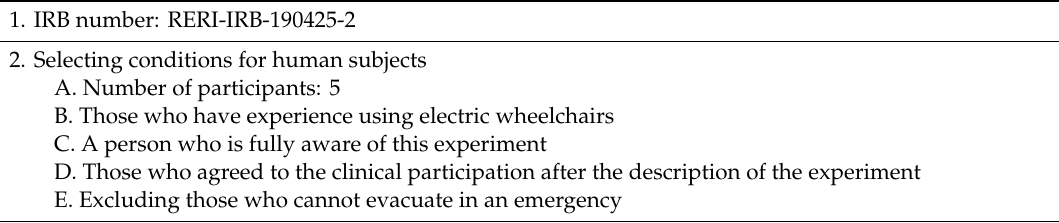
Table 8. Clinical trial